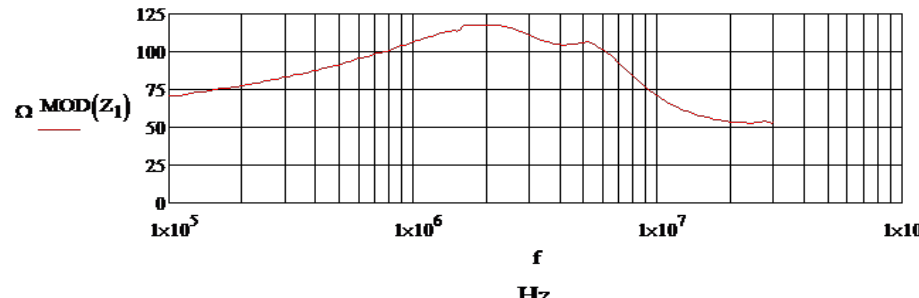
Figure 1. Characteristics of ferrite No. 1.